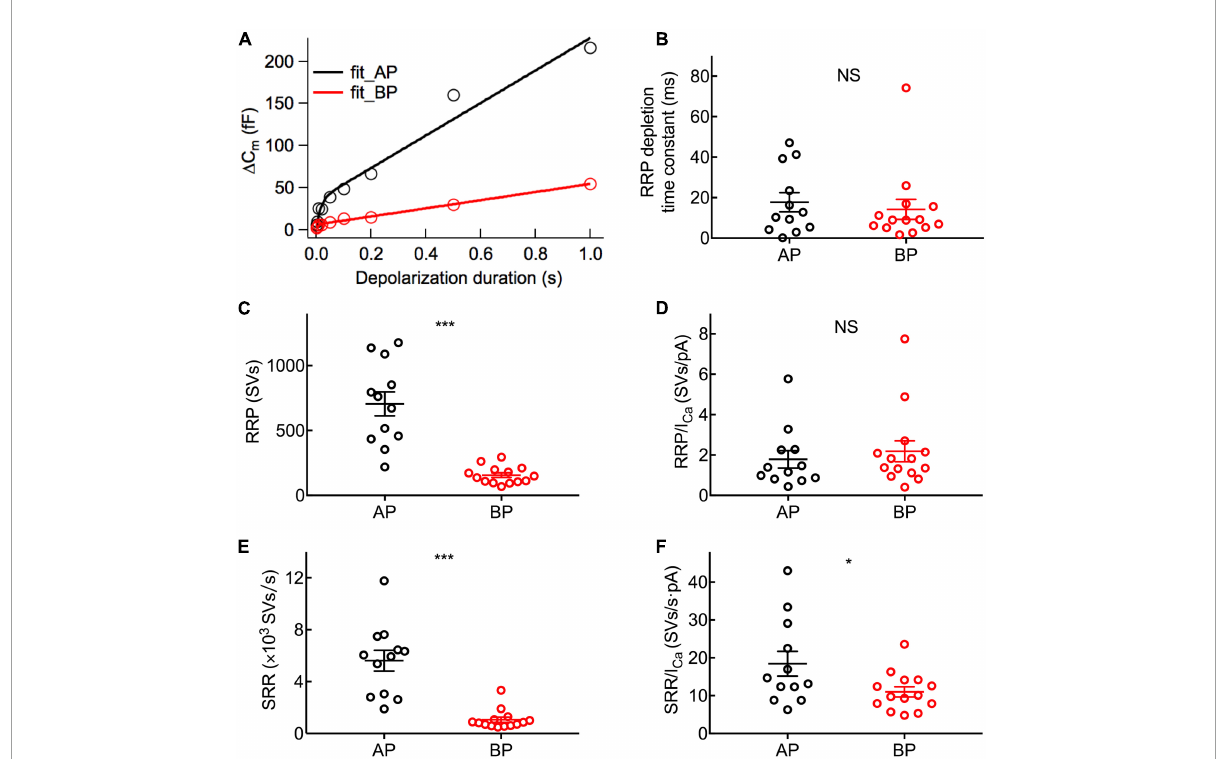
FIGURE5 Dynamics of synaptic vesicle pools in hair cells. The kinetics of vesicle release was investigated by plotting and analyzing capacitance data against pulse duration from Figure 4 . (A) Typical curves obtained by fitting the plots of (cid:49) C m against stimulus time for a pair of AP (black) and BP hair cells (red), respectively. Three parameters of exocytosis were extracted, including time constant ( τ ) to release RRP (B) , RRP (C) , and sustained release rate (SRR) (E) and in AP ( n = 12) and BP ( n = 14) hair cells. (B) There is no significant difference in the time constant to release RRP (17.7 ± 4.71 ms vs. 14.2 ± 4.92 ms; p = 0.61). (C) The RRP consisted of 705 ± 92 and 156 ± 18 synaptic vesicles (SVs) in AP and BP with a ratio of 37 aF/SV, respectively ( p < 0.001). (D) There was no significant difference in the number of RRP vesicles triggered by per unit Ca 2 + influx in AP and BP hair cells (1.79 ± 0.431 SVs/pA vs. 2.18 ± 0.517 SVs/pA; p = 0.57). (E) SRR from AP hair cells (5,615 ± 800 SVs/s) was remarkably faster than that from BP (1,063 ± 200 SVs/s). ( p < 0.001). (F) Dividing SRR by I Ca peak indicated AP has a larger rate of SRP release triggered